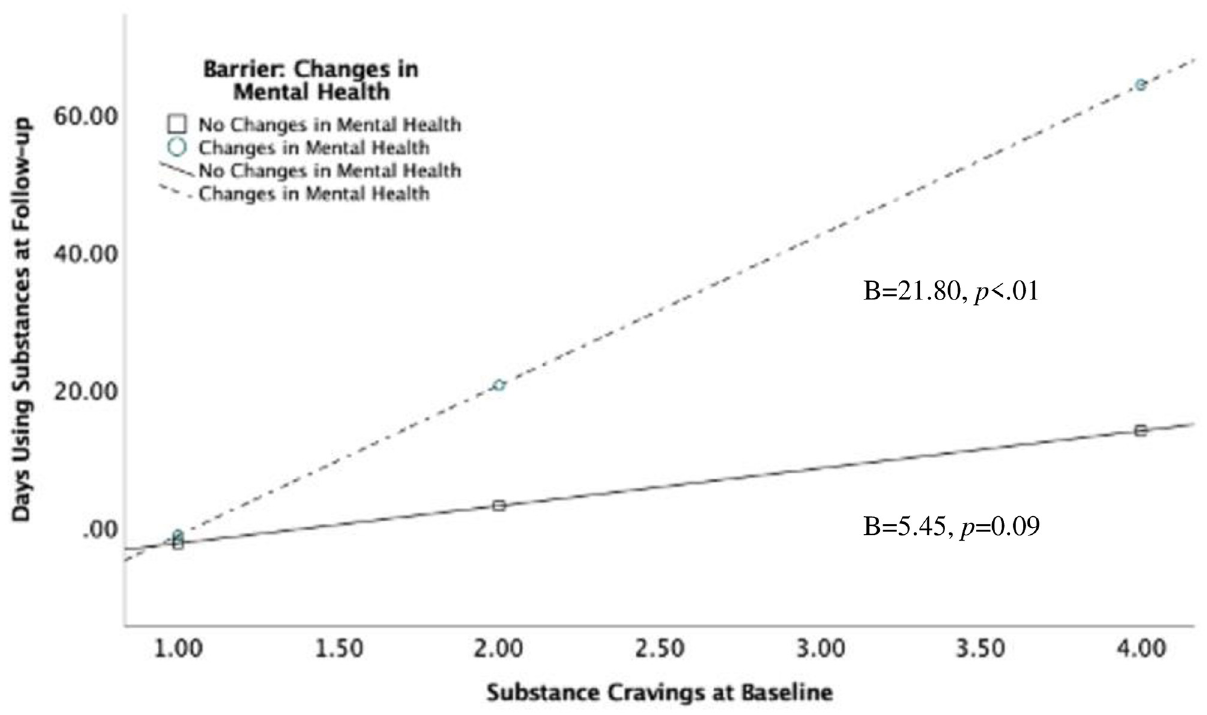
Fig 1. Interactions between baseline substance cravings and changes in mental health to predict later days using substances (n = 48).